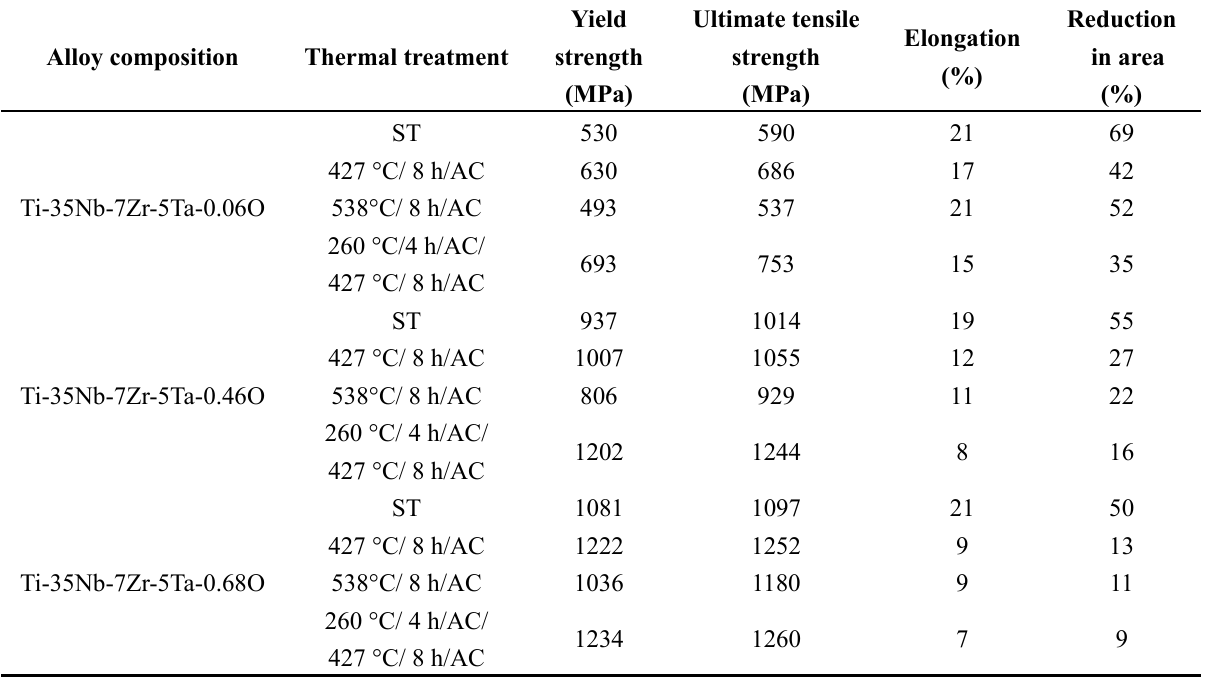
Table 11. Tensile properties of Ti-35Nb-7Zr-5Ta ([140], modified). Reprinted with permission from [140]. Copyright 2006